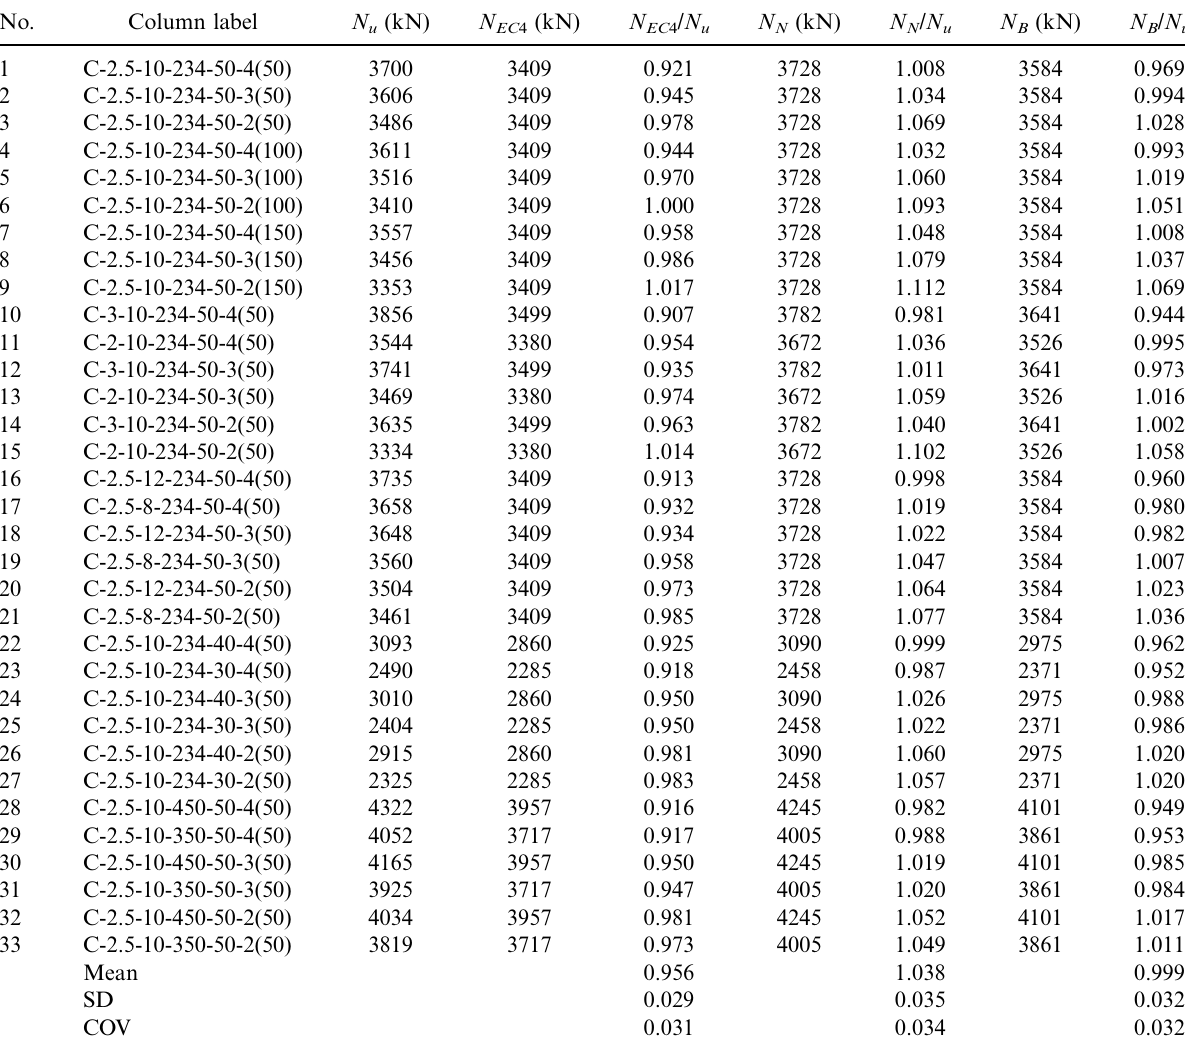
Table 2. Comparison of obtained ultimate axial load capacity ( N u ) with N EC 4 , N N and N B